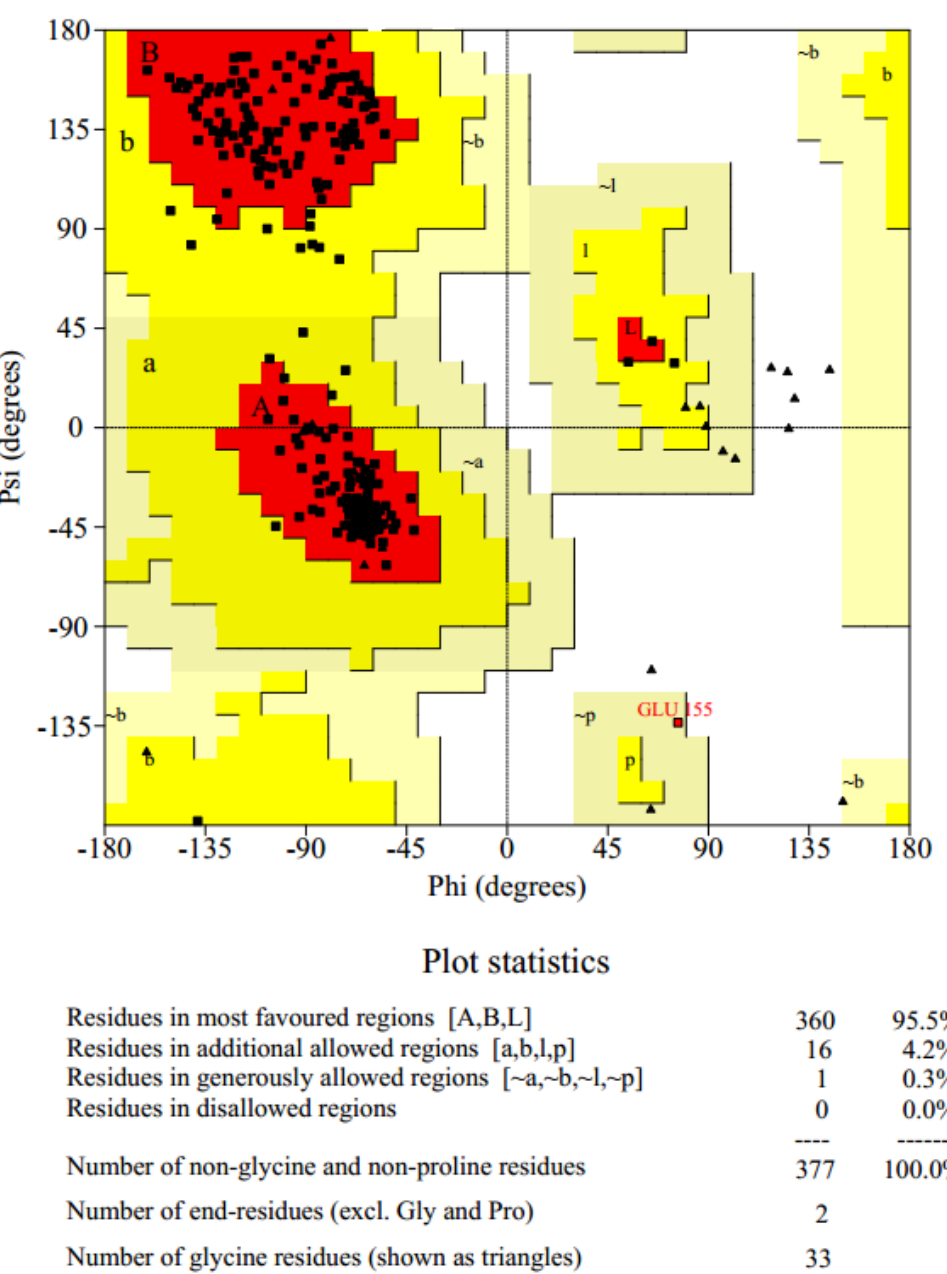
Figure 3. Ramachandran plot of ICL protein structure. This plot provides the general overview of the allowed and disallowed regions of the torsional angle values of the model. Protein with over 90% of its residues in favored regions indicates a model of reasonably high quality.